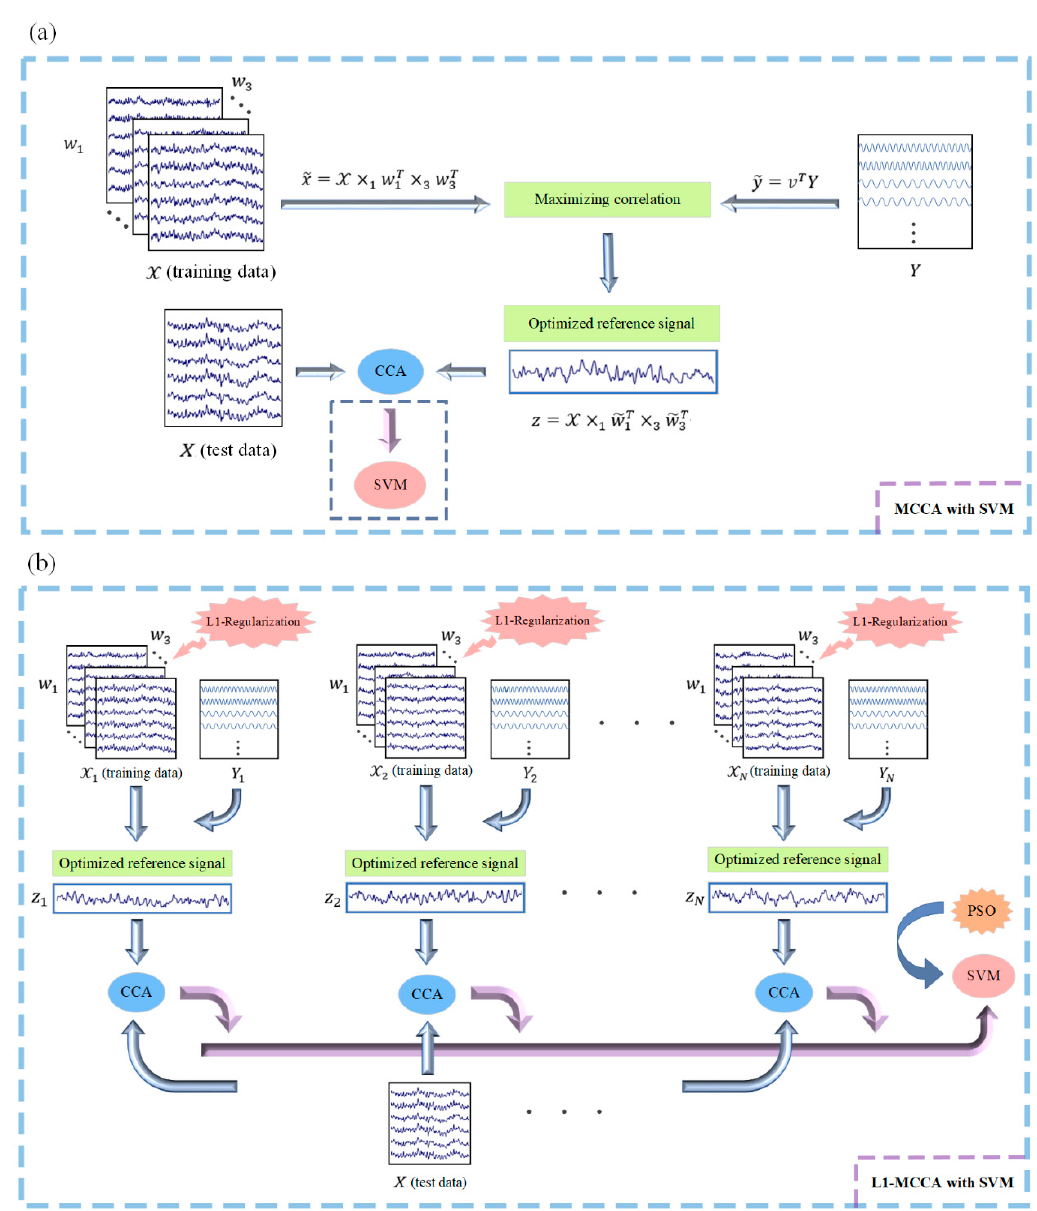
Figure 2. Illustration of the SSVEP classification based on MCCA-SVM and L1-MCCA-SVM. ( a ) MCCA method for reference signal optimization. The three-way tensor ( w 1 , w 3 and v ) and sine-cosine original reference signal ( Y ) composed of part of the experimental sequence are optimized to obtain the optimized reference signal ( z ), and the correlation with the experimental signal is maximized. The classification method can be divided into MCCA whether to combine with SVM. ( b ) L1-MCCA method for reference signal optimization. The L1 regularization based on tensor was introduced to further enhance the optimization of MCCA test channel array. The correlation between the experimental signal ( X ) and the optimized reference signal ( z 1 , z 2 . . . z N ) was maximized, and finally the correlation coefficient was input to the PSO optimized